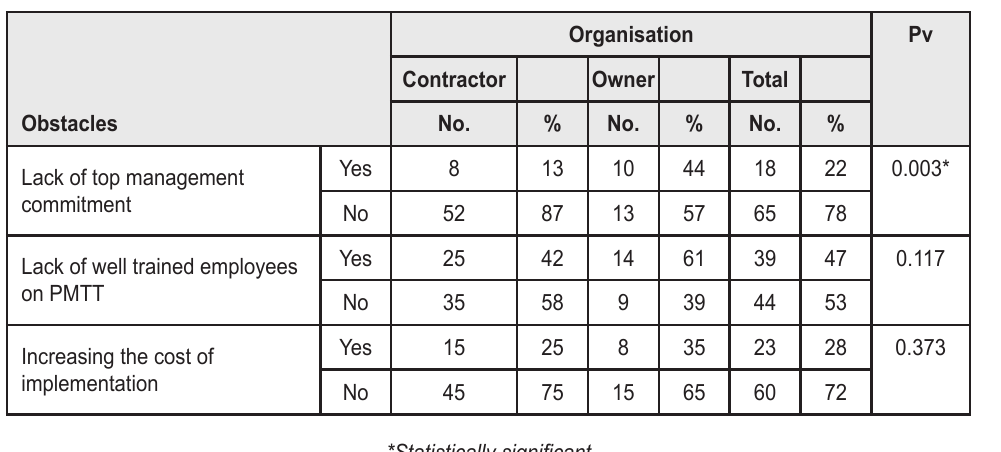
Table 6: Relationship between type of organisation and obstacles o non-efficient implementation of